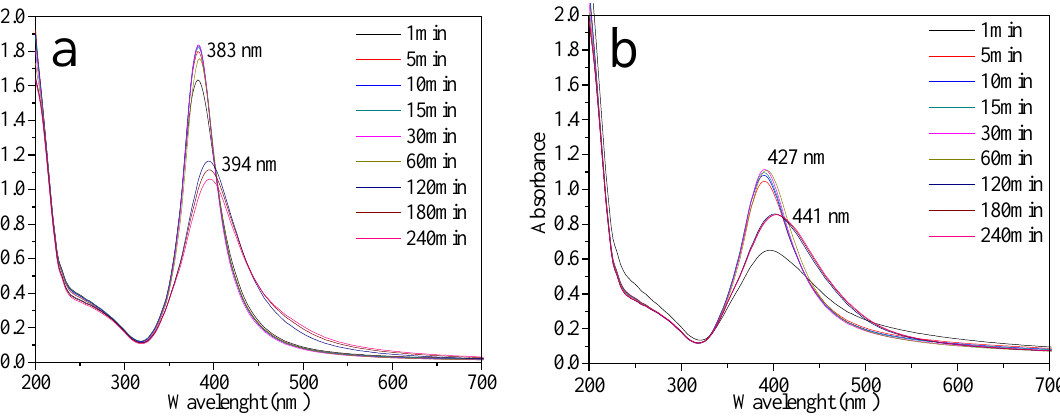
Figure 1. UV-Vis spectra of the AgNPs using NaBH 4 : ( a ) AgNPs P103 0% and ( b ) AgNPs P103 0.1%, both synthesized at 30